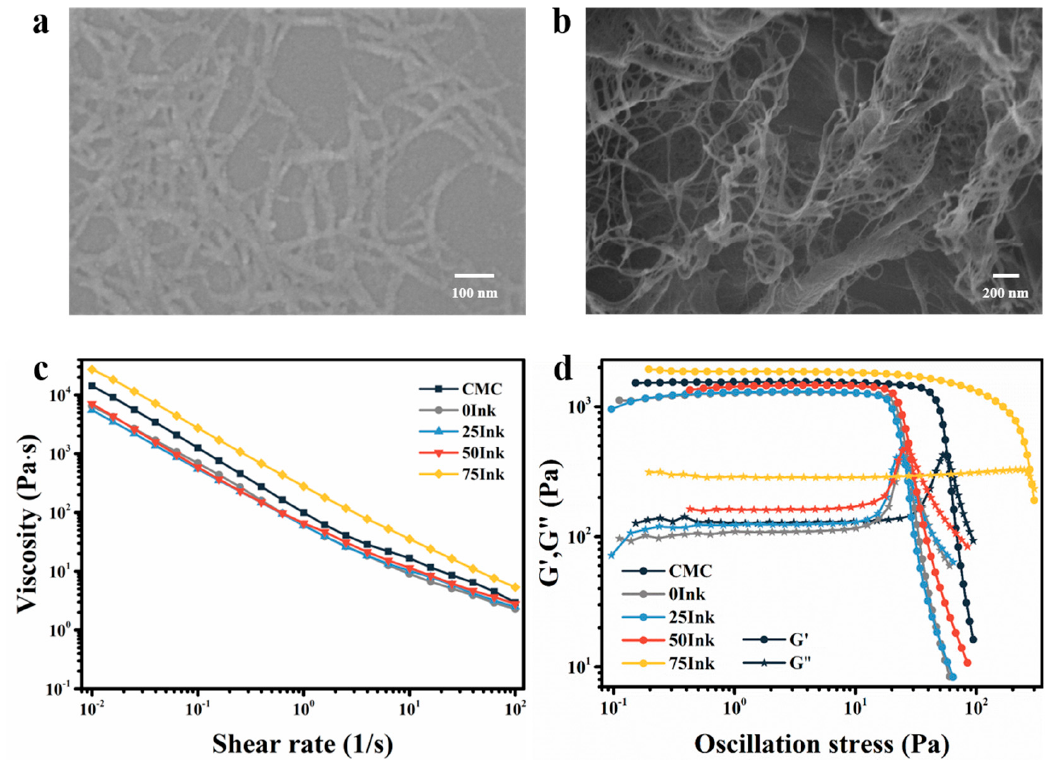
Figure 2. SEM images of CMC ( a ) before and ( b ) after freeze drying. ( c ) Viscosity as a function of the shear rate for CMC and CMC-based inks, ( d ) G’ and G” as a function of the shear stress for CMC and CMC-based inks.